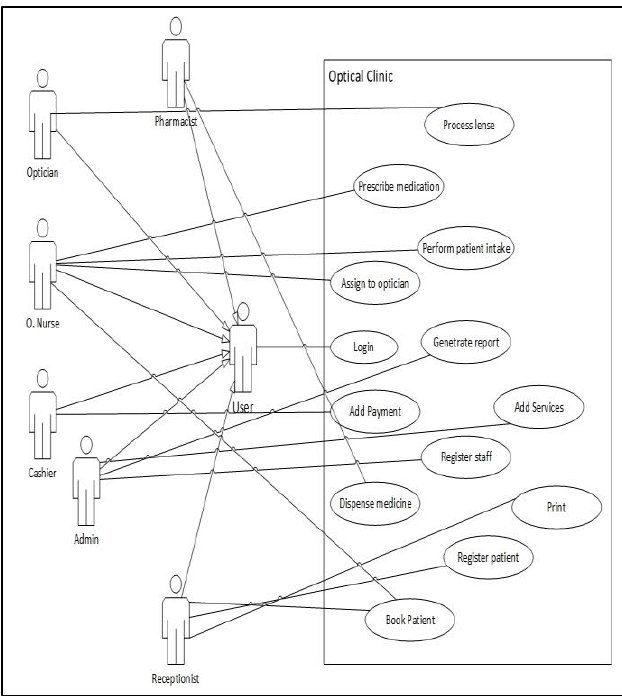
Figure 6. Use Case